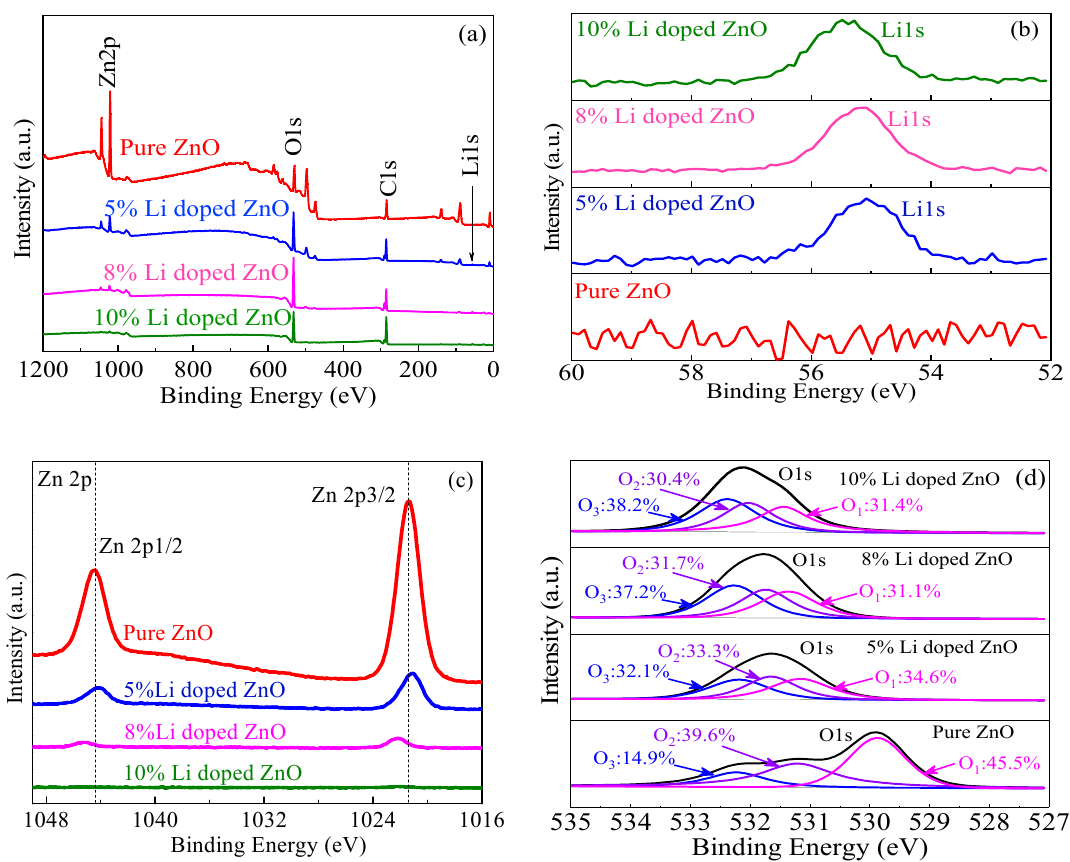
Figure 2. ( a ) X-ray photoelectron spectroscopy (XPS) full survey spectra of pure ZnO, and ZnO thin films with different Li-doping contents; ( b ) Li 1s; ( c ) Zn 2p; ( d ) fitting of O 1s.